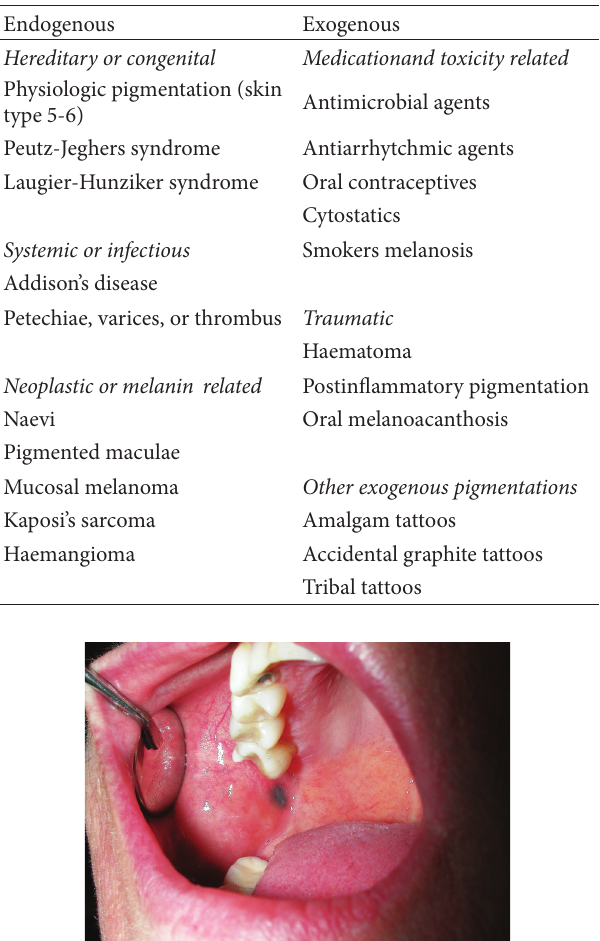
Table 1: Causes of intraoral pigmentation.